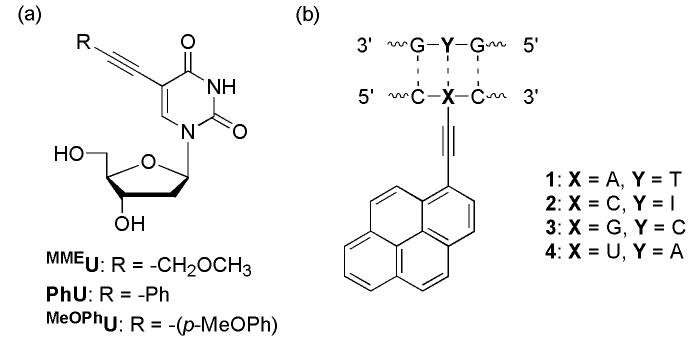
Figure 10. ( a ) 5-Phenylethynyluridine and ( b ) pyrenylethynyl derivatives.